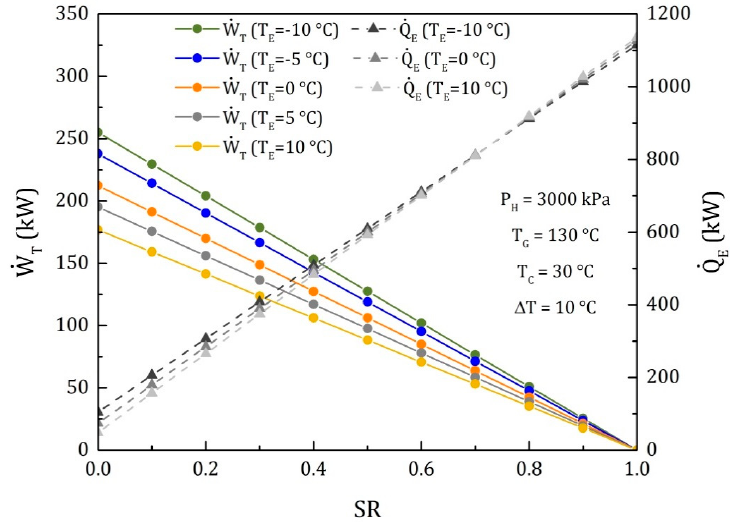
. . Figure 5. W T and Q E as a function of SR for Model II for di ff erent evaporator Figure 5. W(cid:4662) (cid:2904) and Q(cid:4662) (cid:2889) as a function of SR for Model II for different evaporator temperatures.